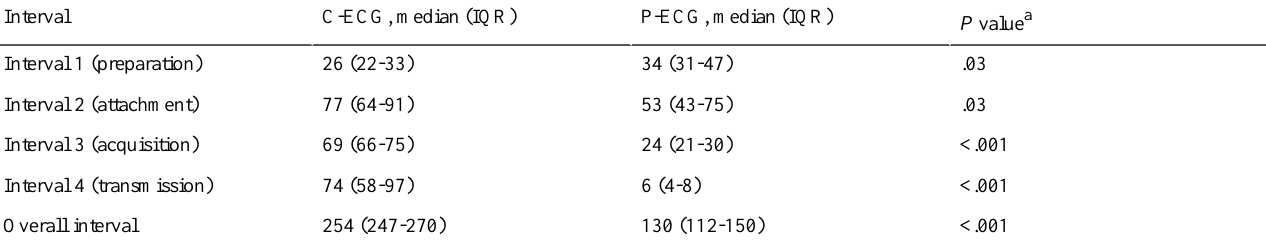
Table 3. Comparison of time intervals between the conventional electrocardiogram (C-ECG) and patchy-type electrocardiogram (P-ECG) devices.